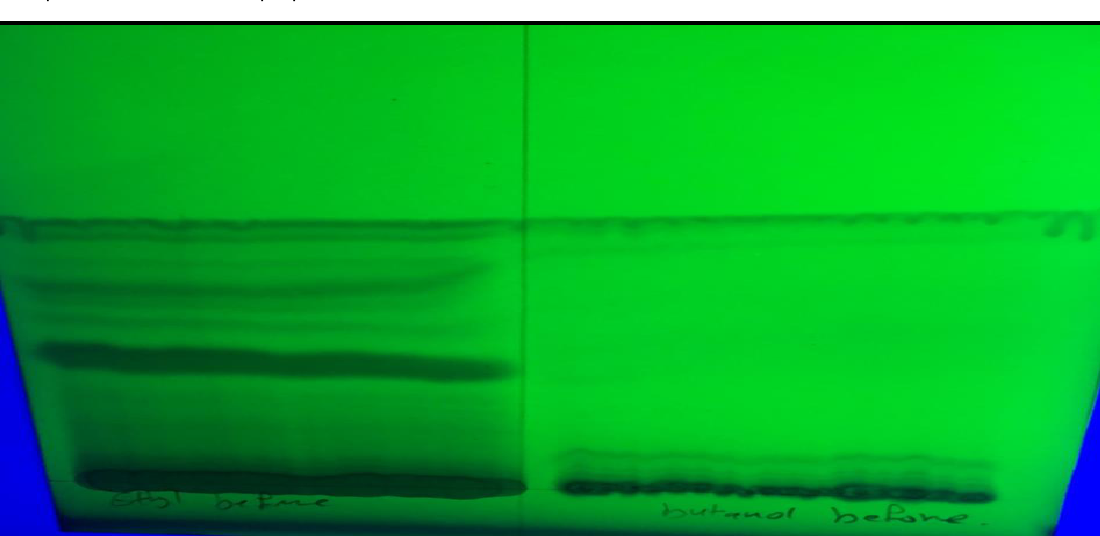
for fractions 254